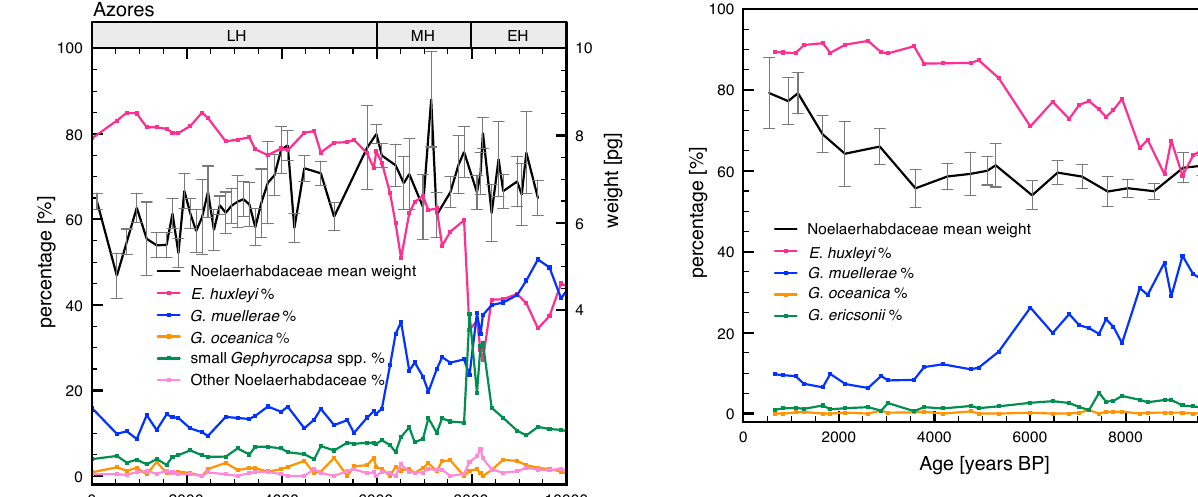
Fig. 6. Relative abundance of Noelaerhabdaceae species at Rockall Plateau from ODP site 980 over the Holocene (Baumann, previ- ously unpublished): E. huxleyi (red line), G. muellerae (blue line), G. oceanica (orange line) and G. ericsonii (green line) in compari- son to the Noelaerhabdaceae mean coccolith weight (black